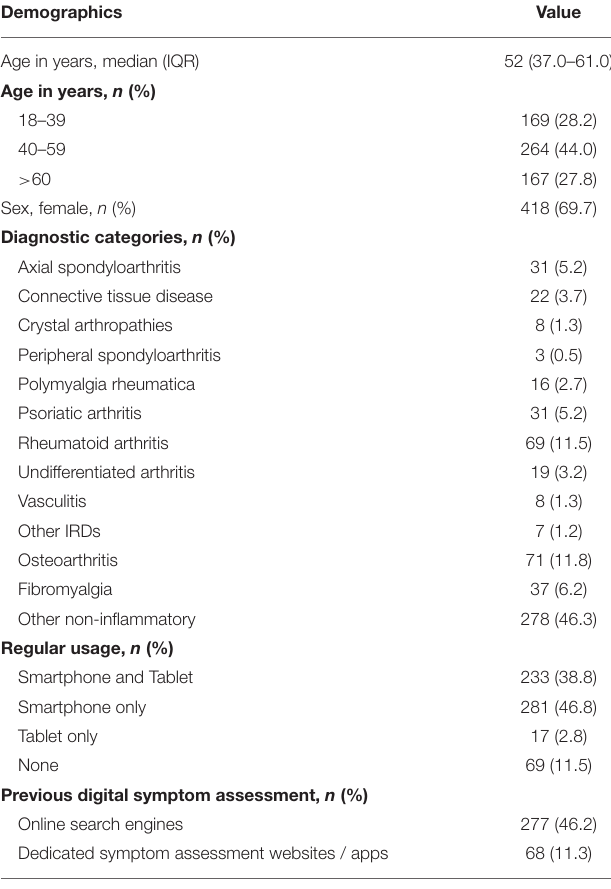
TABLE 1 | Demographics according to final physician’s diagnosis, reported on the discharge summary